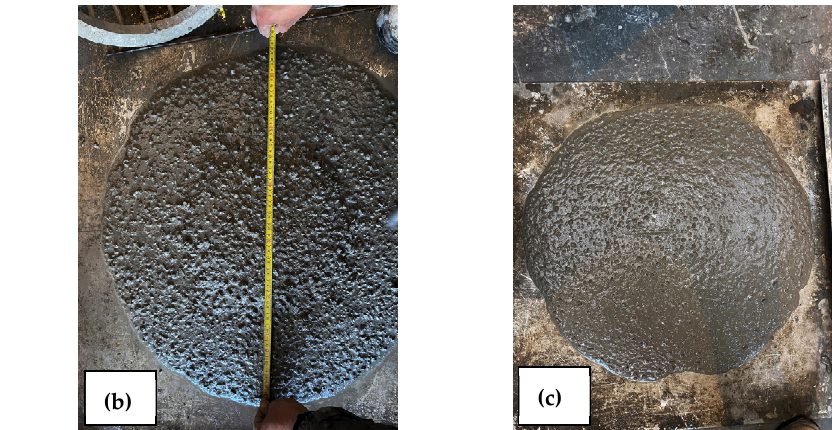
Figure 3. Appearance of the slump flow of the three self-compacting mixes; SCC-C ( a ), SCC-UFS-50 ( b ) and SCC-UFS-100 ( c ).